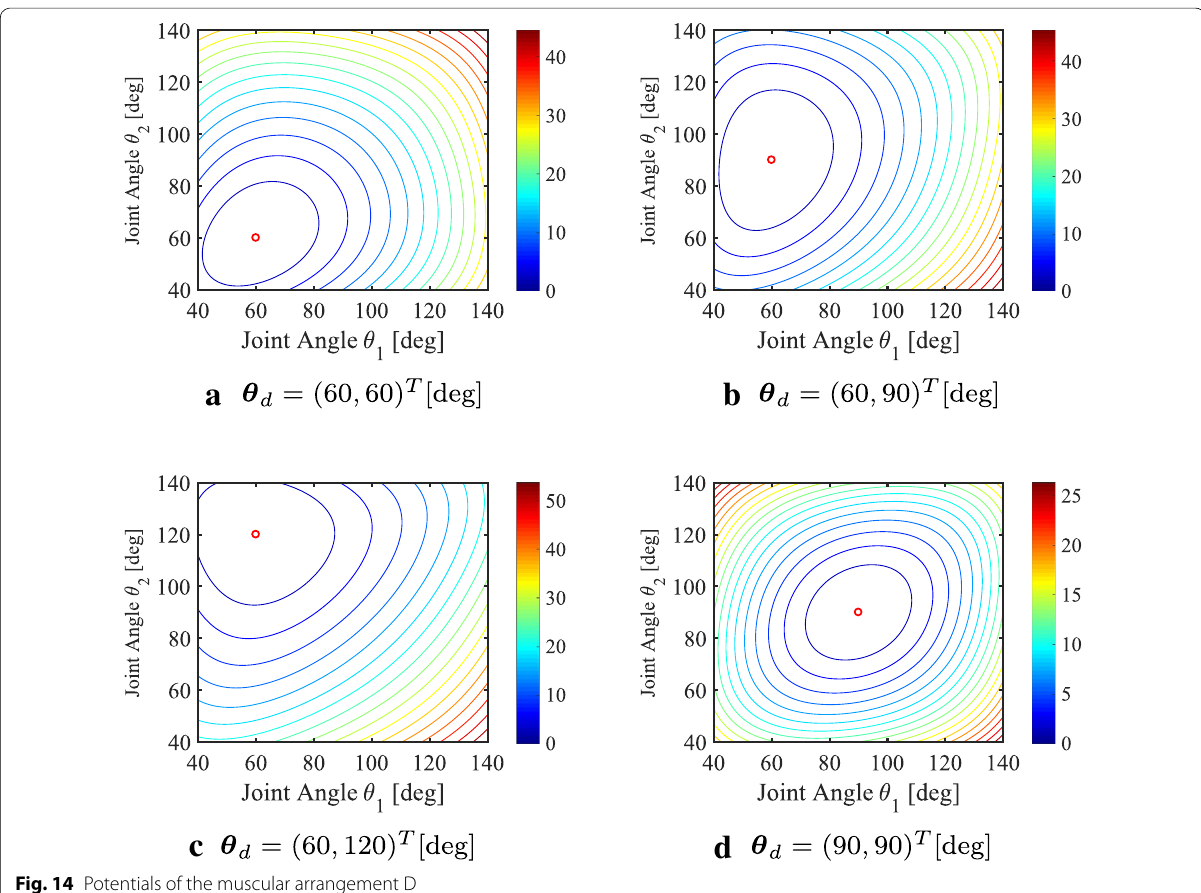
Fig. 14 Potentials of the muscular arrangement